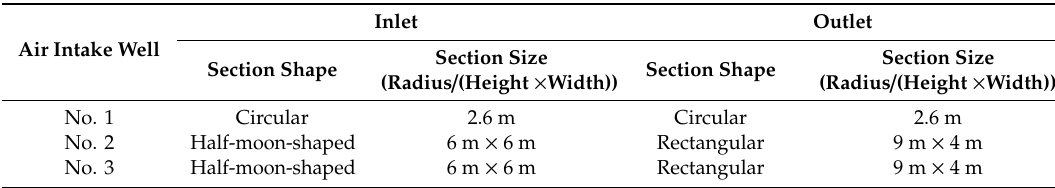
Figure 5. Schematic diagram of the free flow tunnel of the Jinping-I project. Note: AIW is the abbreviation of air intake well. Table 1. Specific parameters of each air intake